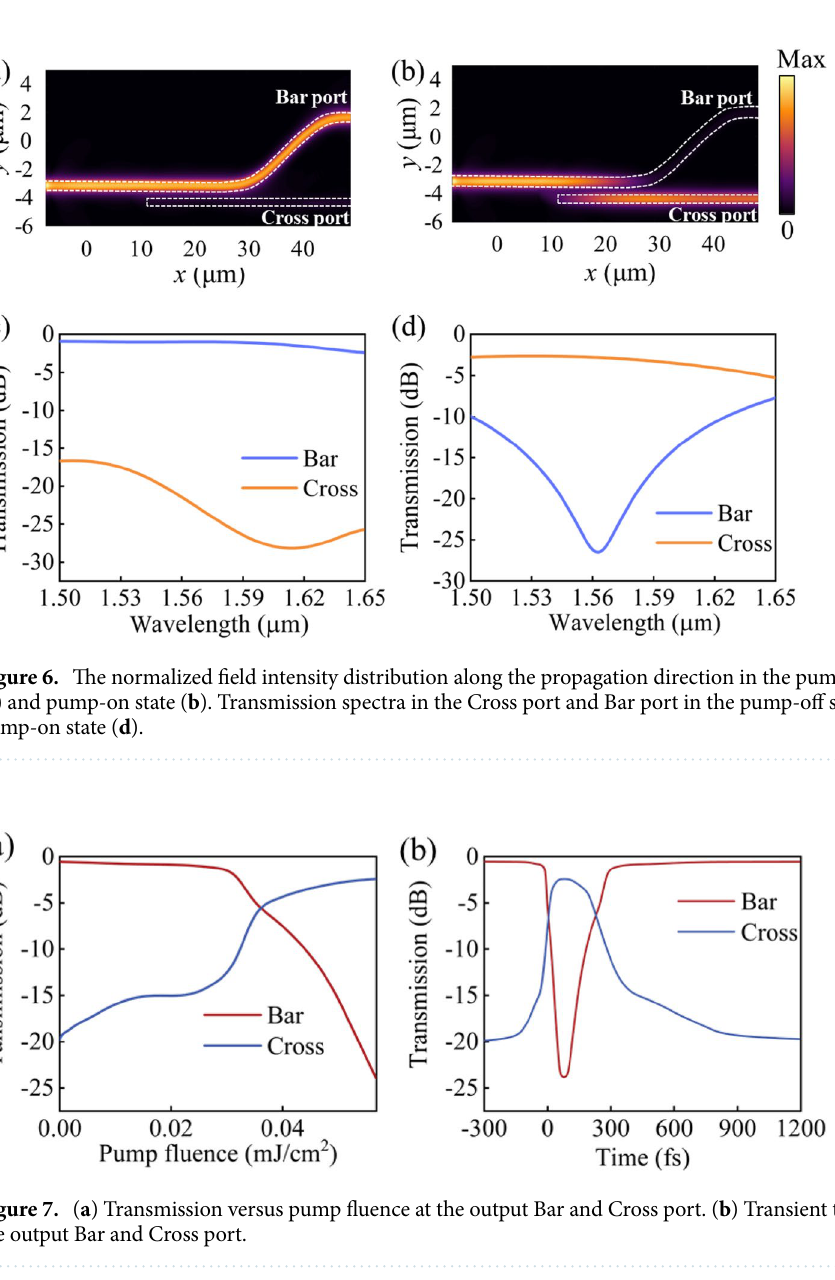
Fig. 7b. Owing to the ultrafast transient response of the TCO layer, the device features a femtosecond magnitude of switching time. For the Cross port, a rising time of 121 fs and a falling time of 532 fs are obtained, while for the Bar port, a rising time of 163 fs and a falling time of 58 fs are attained. Here, the response time of this switch is strongly consistent with excitation and recovery of hot-electrons in the TCO layer. As extensively reported, ENZ effect utilized here is not limited to TCO layer and generally, it can be achieved by other approaches, for instance, plasmonic metamaterials which can effectively improve energy efficiency and make devices more com- pact. In summary, the modulation depth for the bar port is 18.93 dB, while that for the cross port is 19.54 dB. The all-optical switching system shows minimal 3-dB broadband over 1527–1594 nm, and features an ultrafast switching time of 221 fs for the bar port and 652 fs for the cross port. To better characterize the performance of the proposed device, we have summarized the recent works and compared the relevant work in recent years shown in Table 1. The proposed all-optical switch based on ADC exhibits the advantages of large modulation depth, wide bandwidth, and ultrafast switching speed. Noticeably, the interface between CdO and silicon nitride causes scattering across grain boundaries and increases the Drude-damping, which leads to an increase of the insertion loss of the proposed device 43,44 . On the other hand, the existence of the phononic interfacial thermal resistance causes the electron–phonon nonequilibrium near the interface between TCO and SiN. The undesired